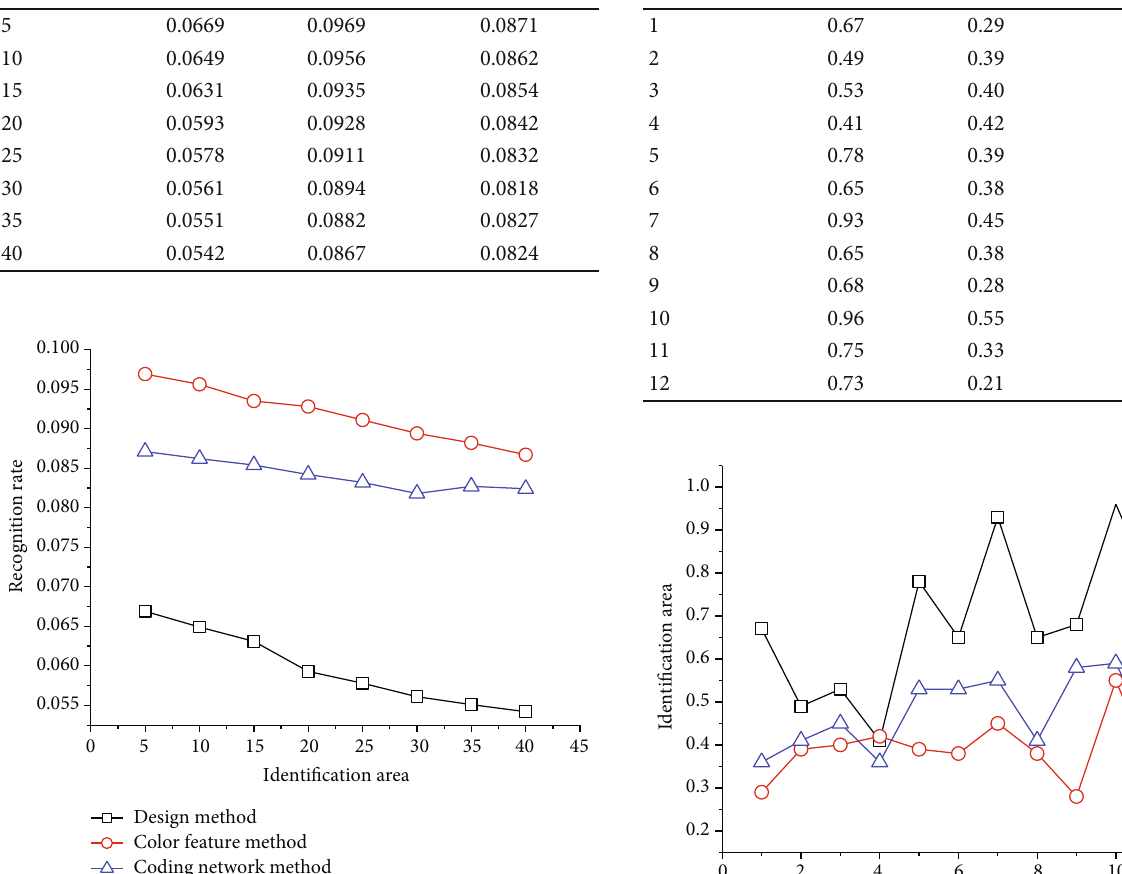
Figure 9: Comparison of recognition rates of di ff erent algorithms.